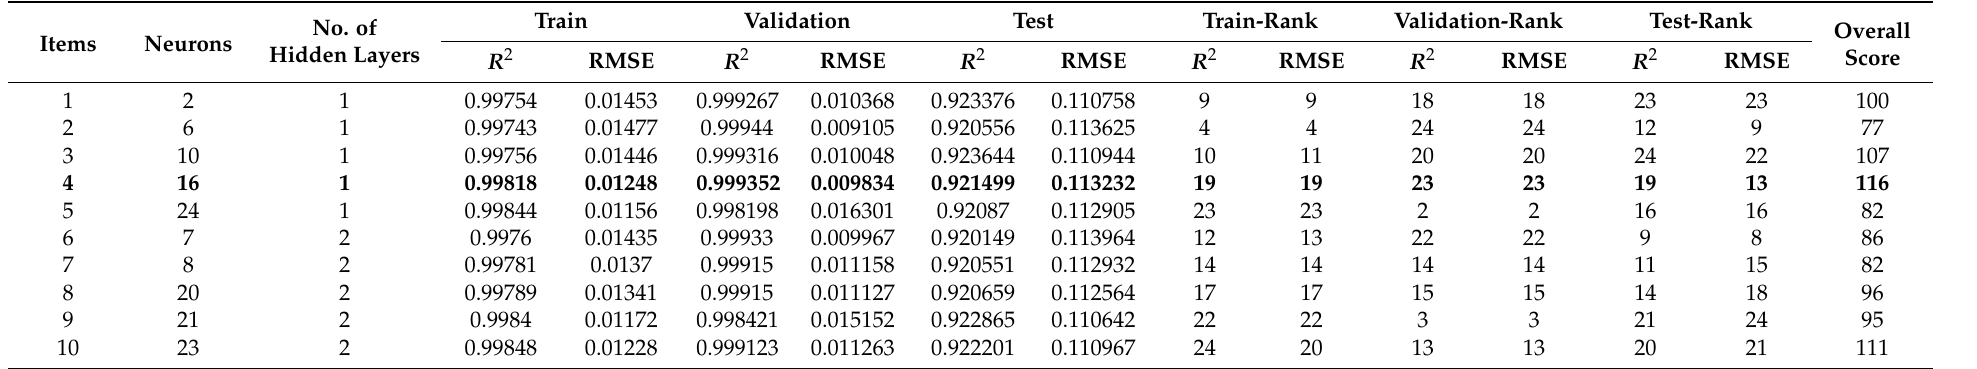
Table 8. Selecting the optimal ANN model with respect to hidden layers and neurons for the Canada